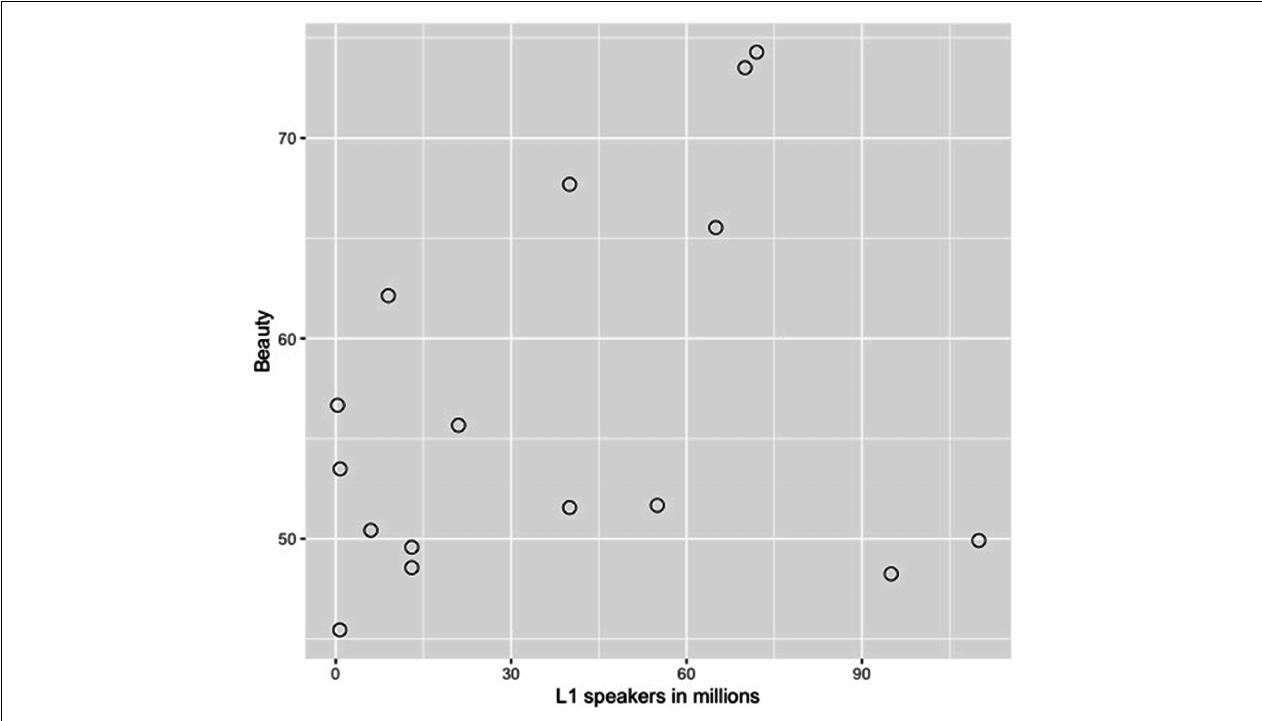
FIGURE 4 | Scatterplot of the correlation between Beauty ratings and the number of speakers in Millions (community size).